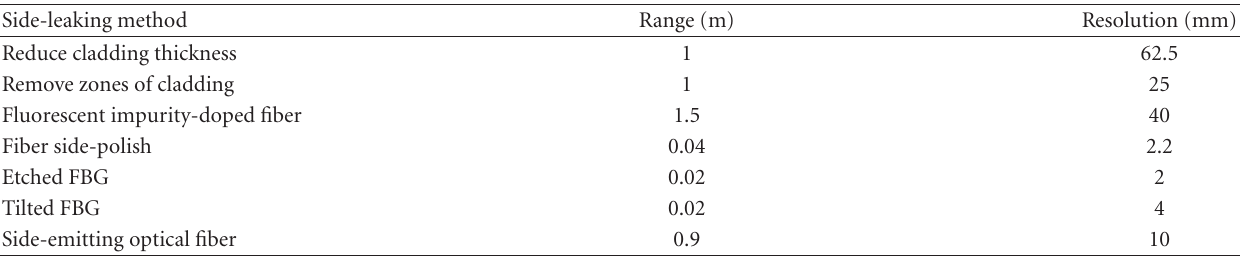
Figure 10: (a) source and detector; (b) top section of sensor; (c) middle section of sensor; (d) end section of sensor. Table 1: Performance of several side-leaking optical fiber level